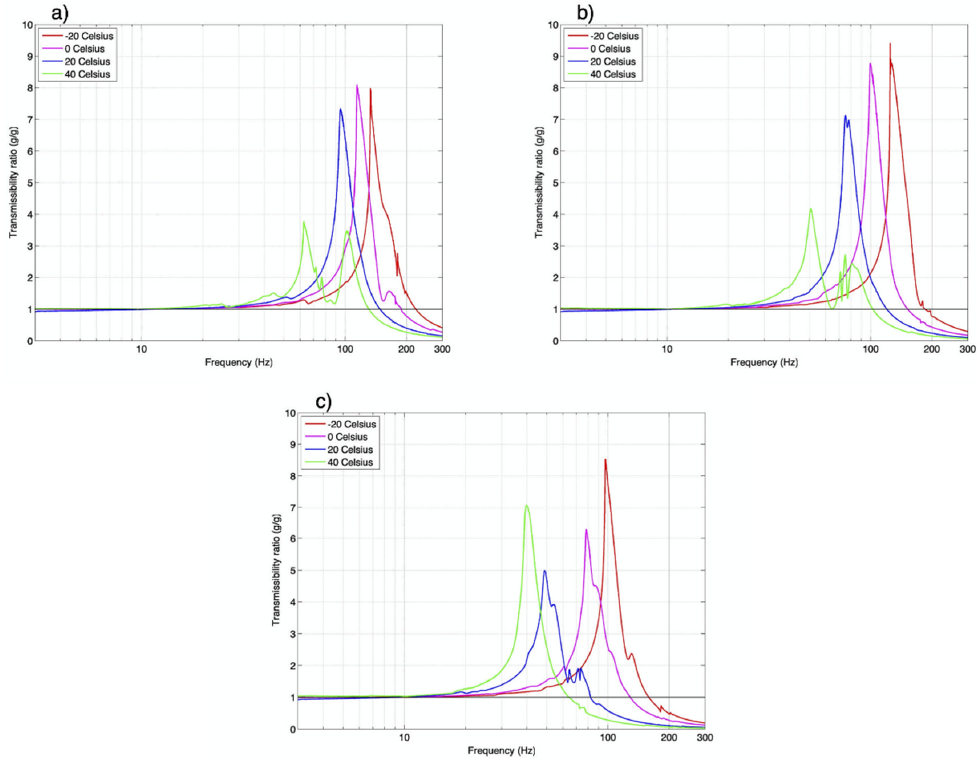
Figure 9. Vibration transmissibility and frequency curves for ( a ) XPE at a static load of 3.488 kPa, ( b ) XPE at a static load of 4.651 kPa, and ( c ) XPE at a static load of 6.976 kPa (frequency is in logarithmic scale).